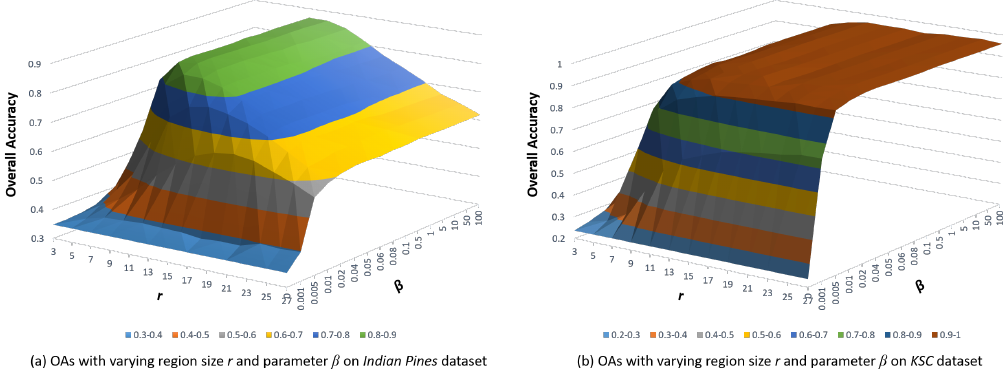
Figure 8. OAs versus the value of parameters r and β in the proposed LWDA method with NN classifier on the ( a ) Indian Pines and ( b ) KSC datasets using τ =